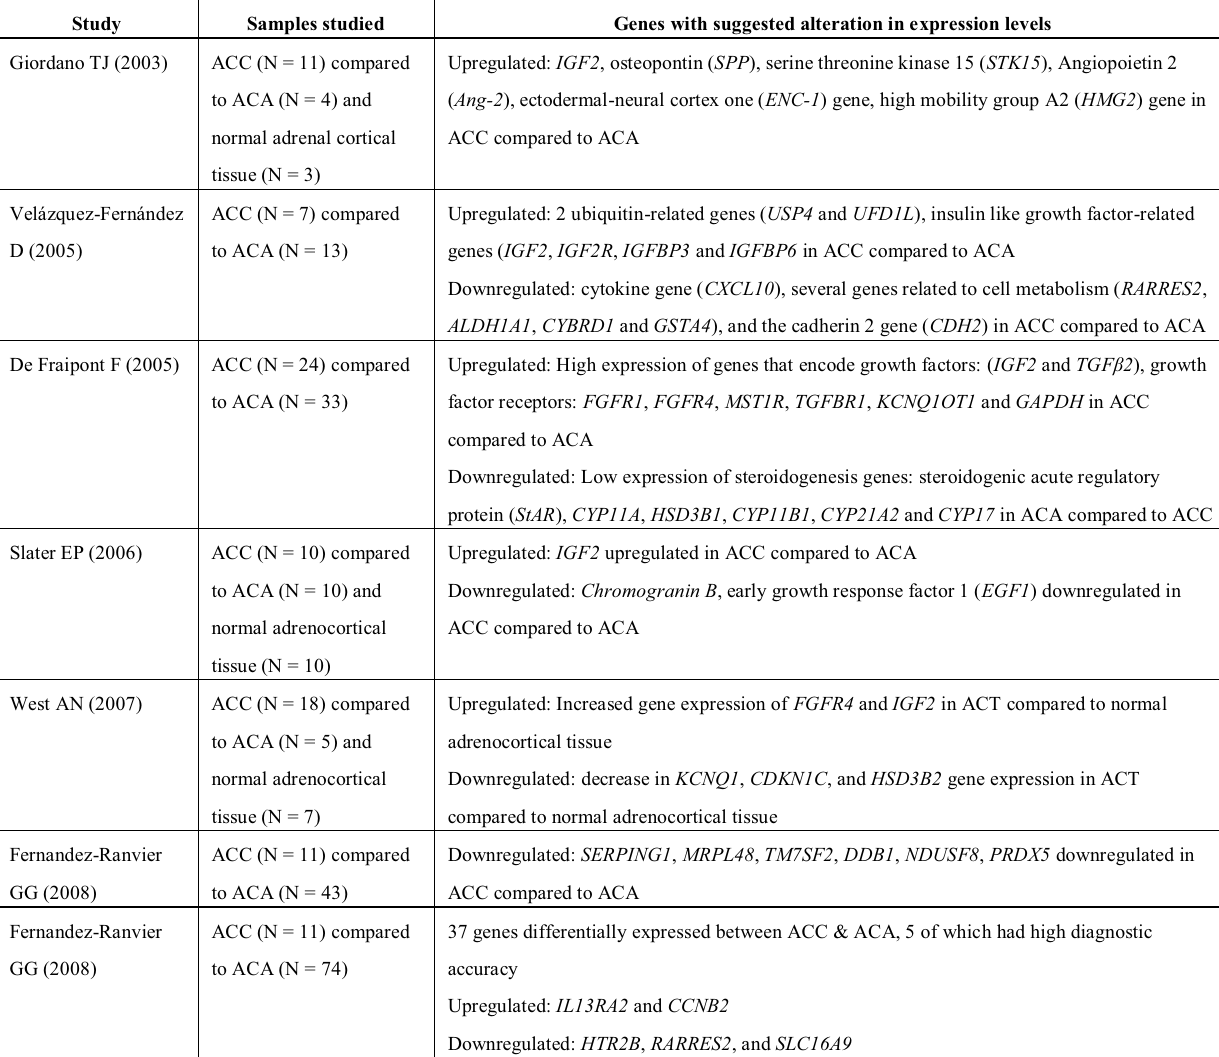
Table 1. Gene expression profiling studies performed in adrenocortical